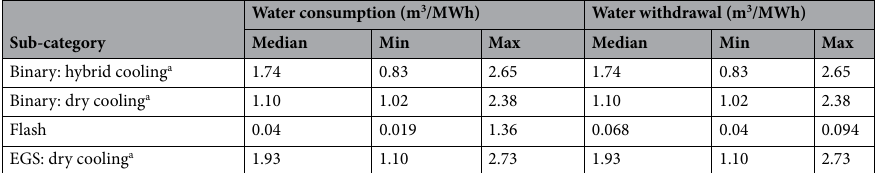
Table 12. Geothermal-generated power plant’s water withdrawal and consumption data 69 . a Reflecting data limitations and the nature of water use, we assume withdrawal and consumption are equal for all estimates in this category.